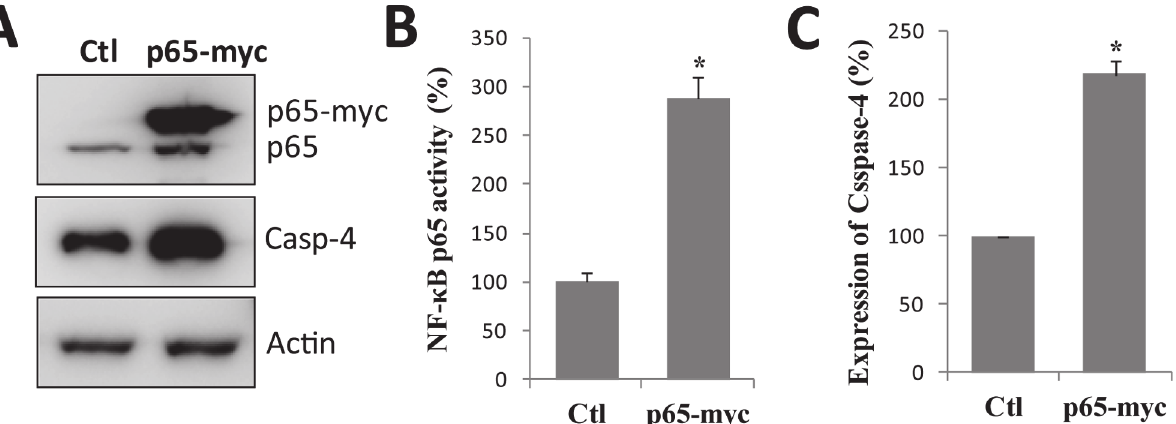
Fig 4. NF- κ B p65-overexpression increases caspase-4 expression. ( A ) NF- κ B p65 was transiently overexpressed in SH-EP1 cells, and the expression of p65 and caspase-4 were analyzed by Western blotting with the corresponding antibodies. ( B ) The expression level of caspase-4 protein was quantified. The caspase-4 level of p65-overexpressing cells is expressed as a percentage of that measured in control SH-EP1 cells. ( C ) The relative mRNA levels of caspase-4 in p65-overexpressing cells were determined by qPCR. Data are representative of three independent experiments and shown as average ± s.e.m. (bars) values. *** P <